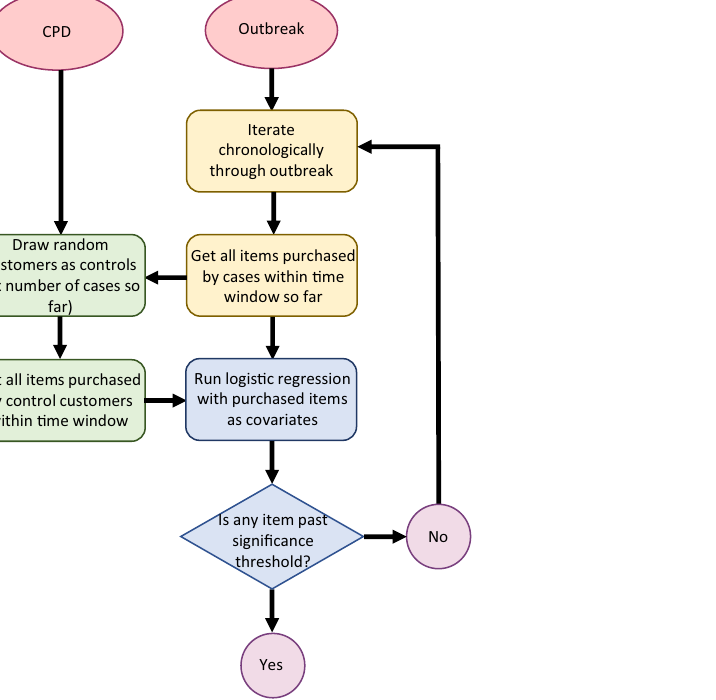
Figure 2. Flowchart of outbreak